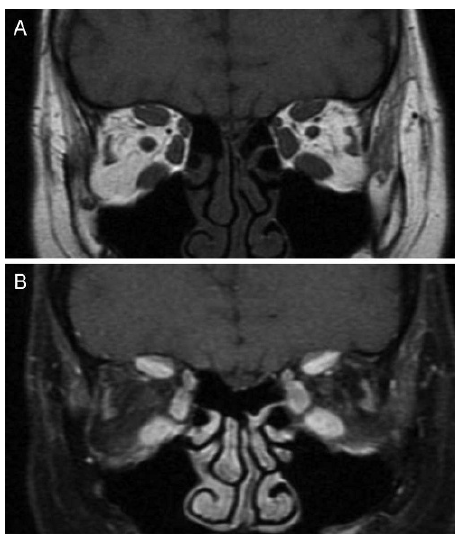
Figure 4 - Coronal T1-weighted MR images from a patient with active Graves’ orbitopathy. A) Image showing enlargement of the extraocular muscles without fatty degeneration. B) Fat- suppressed and gadolinium-enhanced image showing a bright signal from the inferior, medial and superior recti